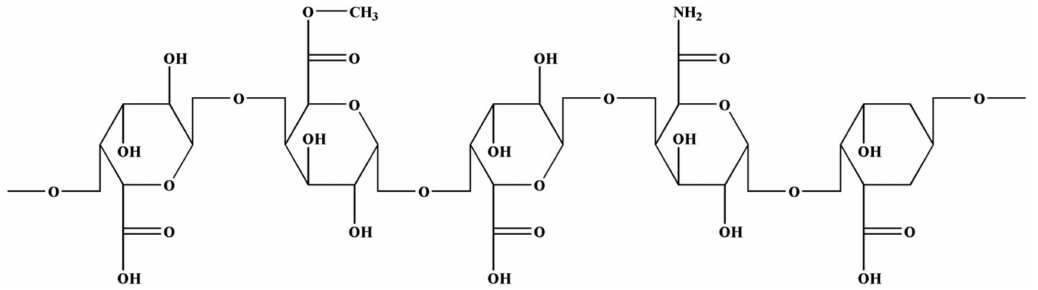
Figure 2. Structure of apple